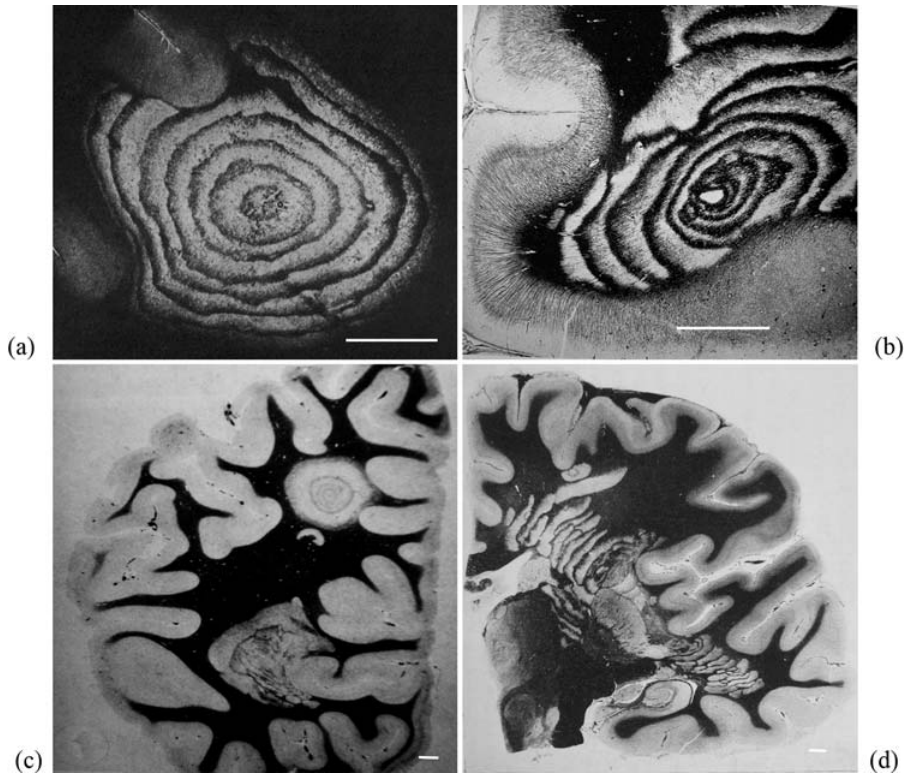
Figure 1. Typical aspects of Balo´’s concentric sclerosis. (a) Original case of Balo´; several anastomoses are located in the lower half of the lesion (from Balo´ (1928) Arch Neurol Psychiatr 19 :242–264). (b) Lesion centered by a veinule showing ring fragmentation in a constrained area (from Hallervorden et al. 1933). (c) Lesion reproduced from Castaigne et al. (1984) Rev Neurol 140 :479–487. (d) Progress of the pathologic process from a center located in a constrained area, showing formation of bands (from Behr (1950) Dtsch Z Nervenheilk 164 :480–489). Loyez staining (myelin in black, destroyed areas in white); scale bars: 1 cm.